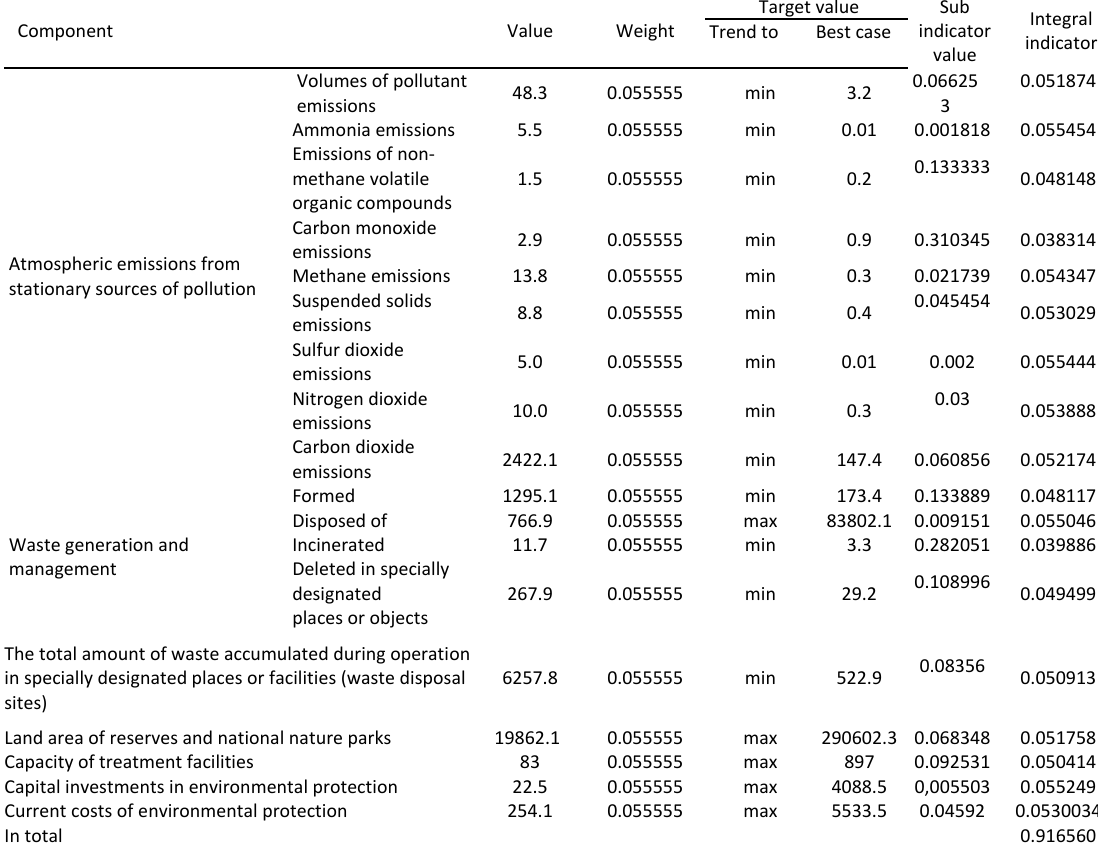
Table 4: Calculations of the integral indicator of the ecological competitiveness: Cherkaska region casein 2020